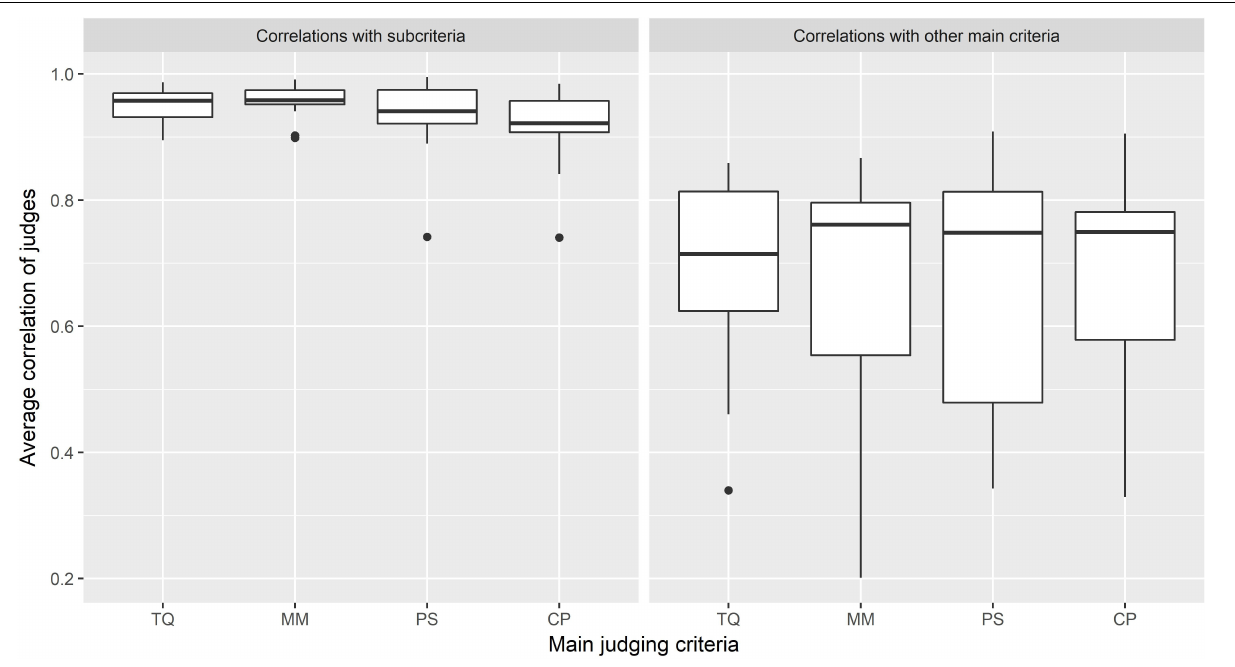
FIGURE 2 | Average correlations between each of the main criteria and it’s sub-criteria and between each of the main criteria and other main criteria by judges.